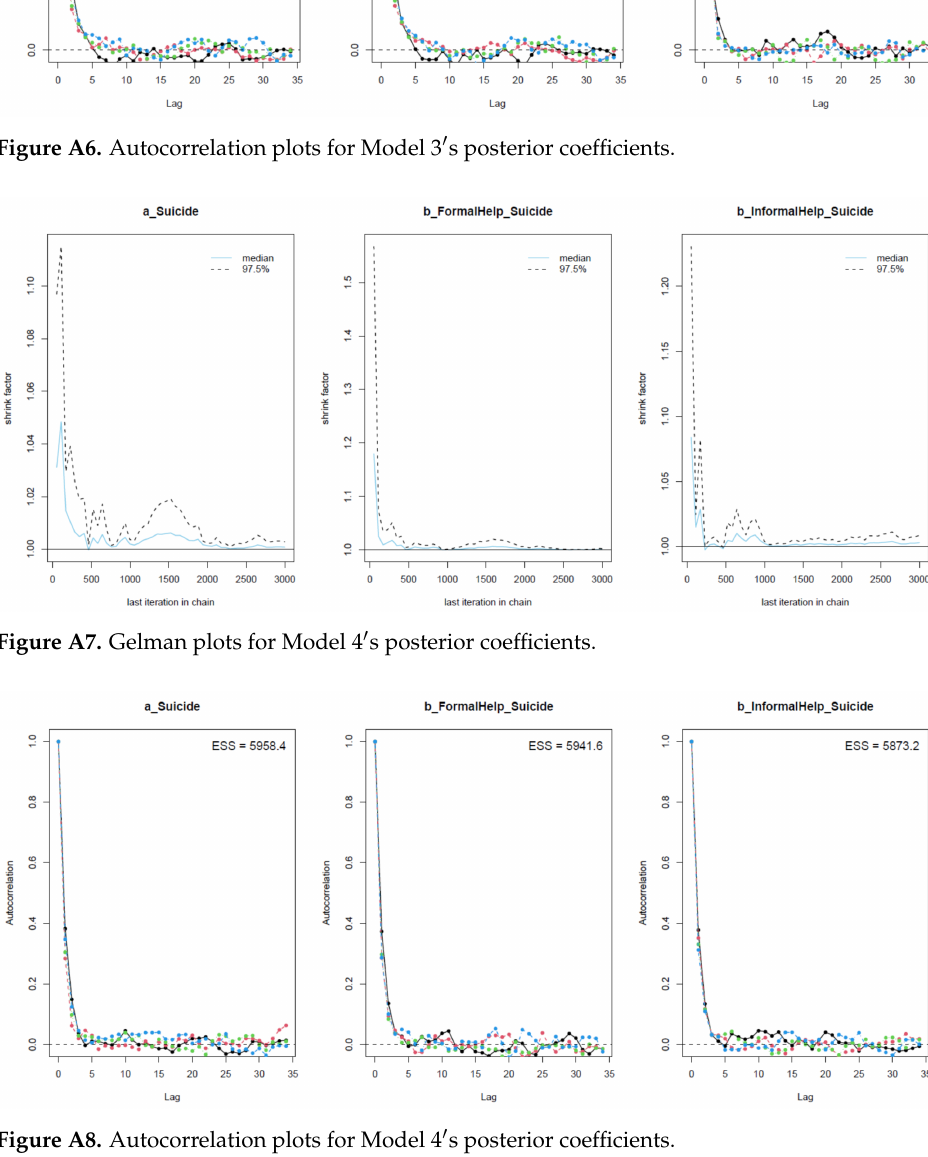
Figure A8. Autocorrelation plots for Model 4 (cid:48) s posterior